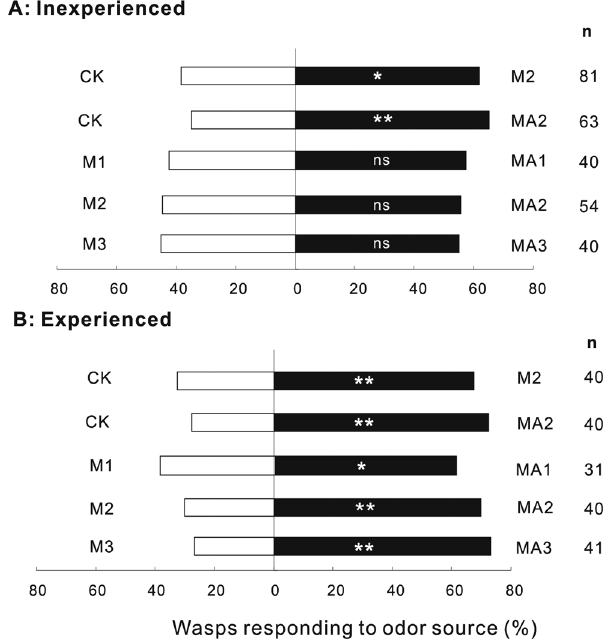
Figure 1. Attraction of experienced and inexperienced A . bambawalei females to plants with and without mealybugs that were tended or not tended by ants (experiment 1). Control plants were not infested with mealybugs or ants. Other plants were infested with 30, 60, or 90 mealybugs (and therefore had mealybug damage) without ant infestation (treatments M1, M2, and M3, respectively) or with ant infestation (treatments MA1, MA2, and MA3, respectively). Pairs of plants were then used in an olfactometer assay with ( A ) experienced A. bambawalei females (previously exposed to plant volatiles) or ( B ) inexperienced A. bambawalei females (not previously exposed to plant volatiles). Bars represent the percentages of wasps choosing either of the odor sources (binomial test; * P < 0.05, ** P < 0.01; ns, not